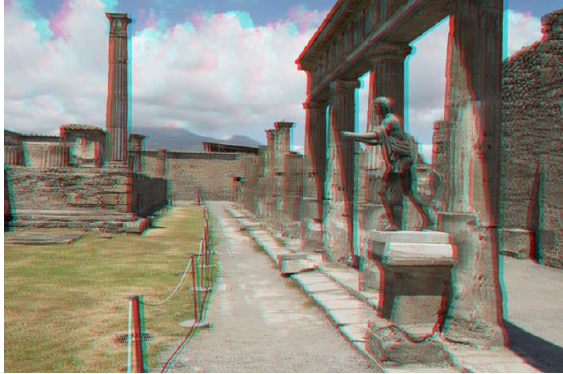
Figure 7. Anaglyph red - cyan of Apollo’s Temple